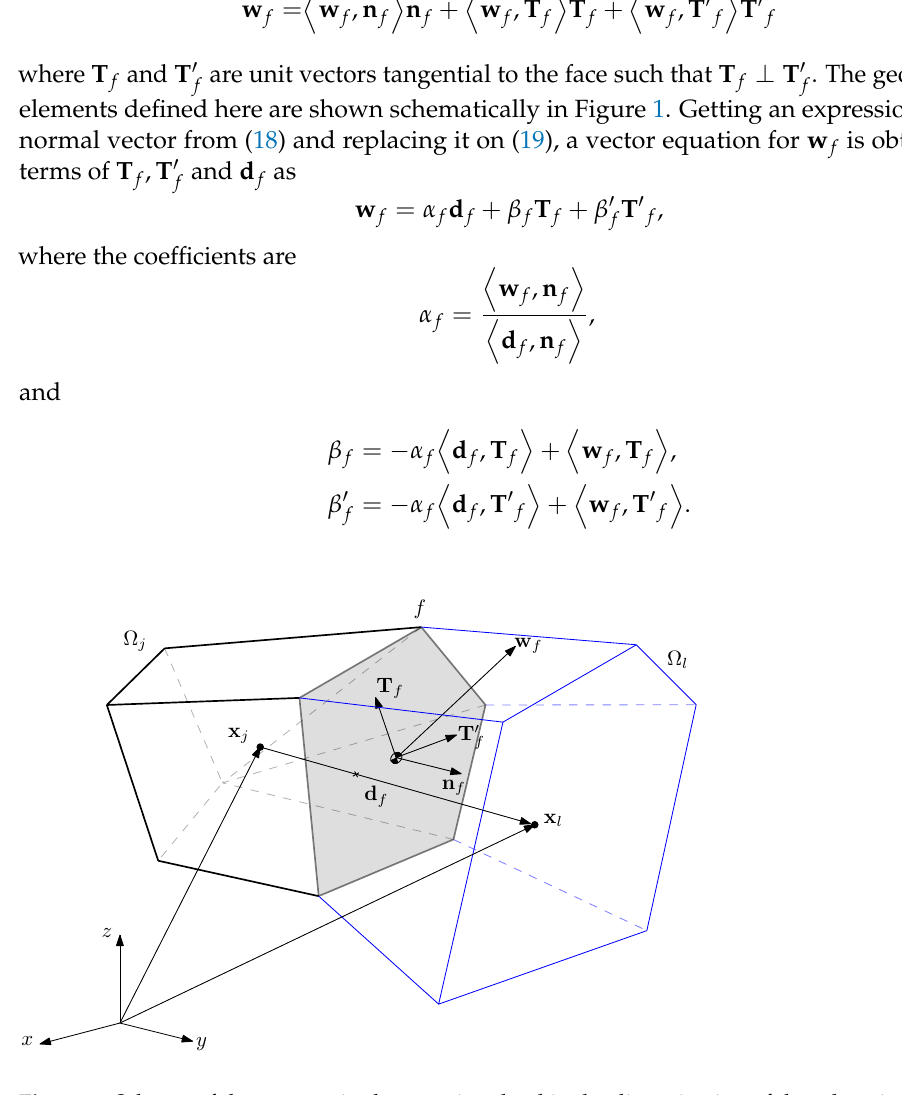
Figure 1. Scheme of the geometric elements involved in the discretization of the advective